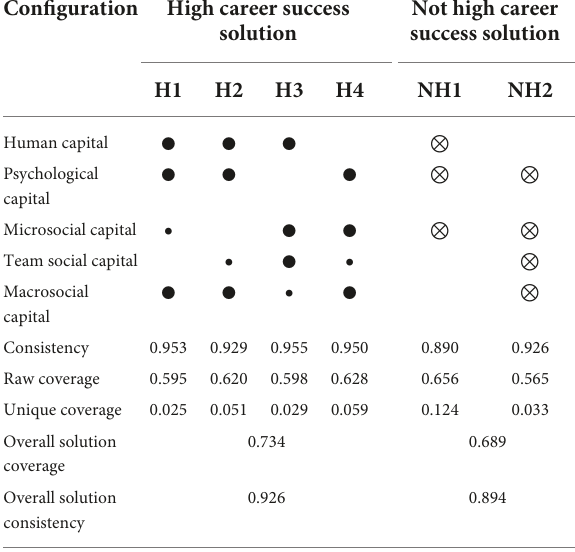
TABLE 6 Combinations of conditions for high and non-high career success rates.